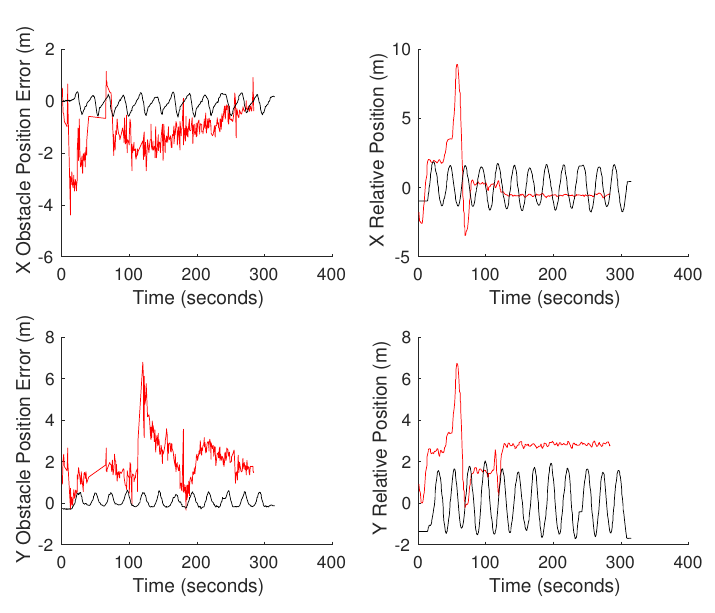
Figure 12. Continuous obstacle position test conducted with first-generation Piksi. Red shows the data associated with the UAV, while black is the data for the UGV.